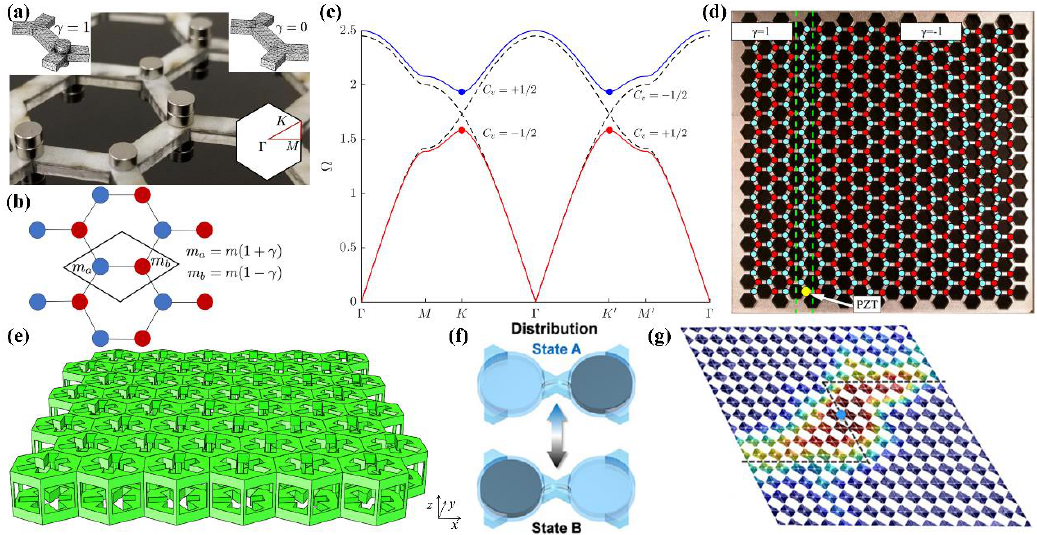
Figure 3. Analogue valley Hall insulators. ( a ) The experimental continuous elastic plate [76]. ( b ) The hexagonal mass-spring lattices [76]. ( c ) The energy spectrum with γ = 0 (dashed black line) and γ = + 0.2 (solid red and blue lines). The valley Chern numbers are marked at the corresponding energy extrema in momentum space [76]. ( d ) The elastic plate with line interface consists of the left strip ( γ = 1 ) and right strip ( γ = − 1 ). The red (cyan) dots represent two(zero) cylinders attached to the plate [76]. ( e ) The bilayer phononic crystal slabs of a hexagonal lattice [74]. ( f ) The magnetic fluid distribution in a unit cell [79]. ( g ) The measured displacement field for the Z-shaped interface structure